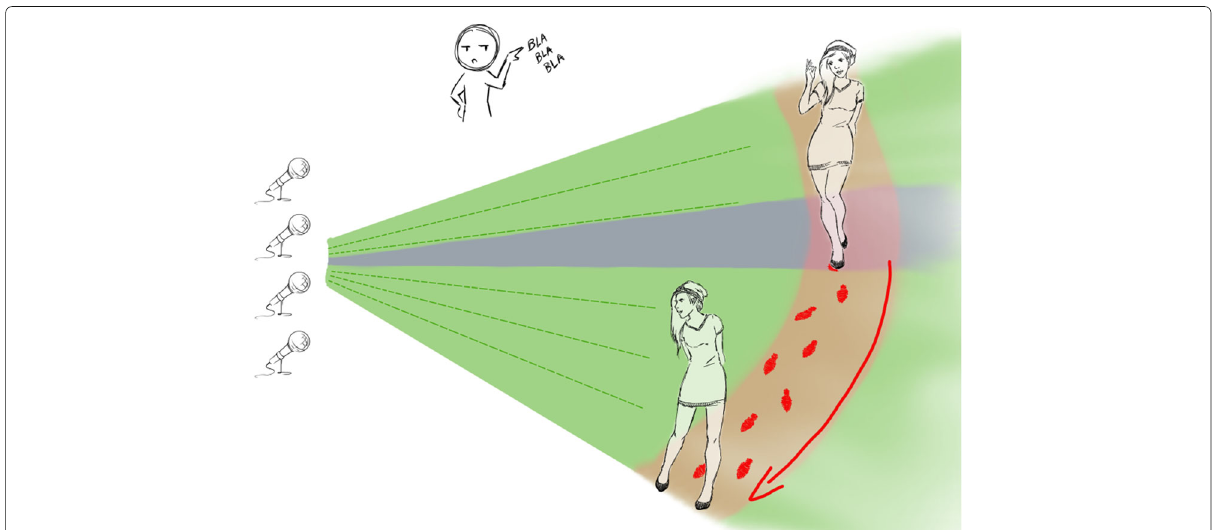
Fig. 1 How the blind extraction of a moving speaker can be solved based on CSV. The narrow area (in gray) stands for a typical focus of a separating filter obtained by the static mixing models. It is able to extract the speaker only from a particular position. The green area denotes the focus of a separating filter obtained through CSV: it covers the entire area of the speaker’s movement during the recording. Such separating vector exists because there is a sufficient number of microphones and because the interfering speaker is located outside the area of the target speaker